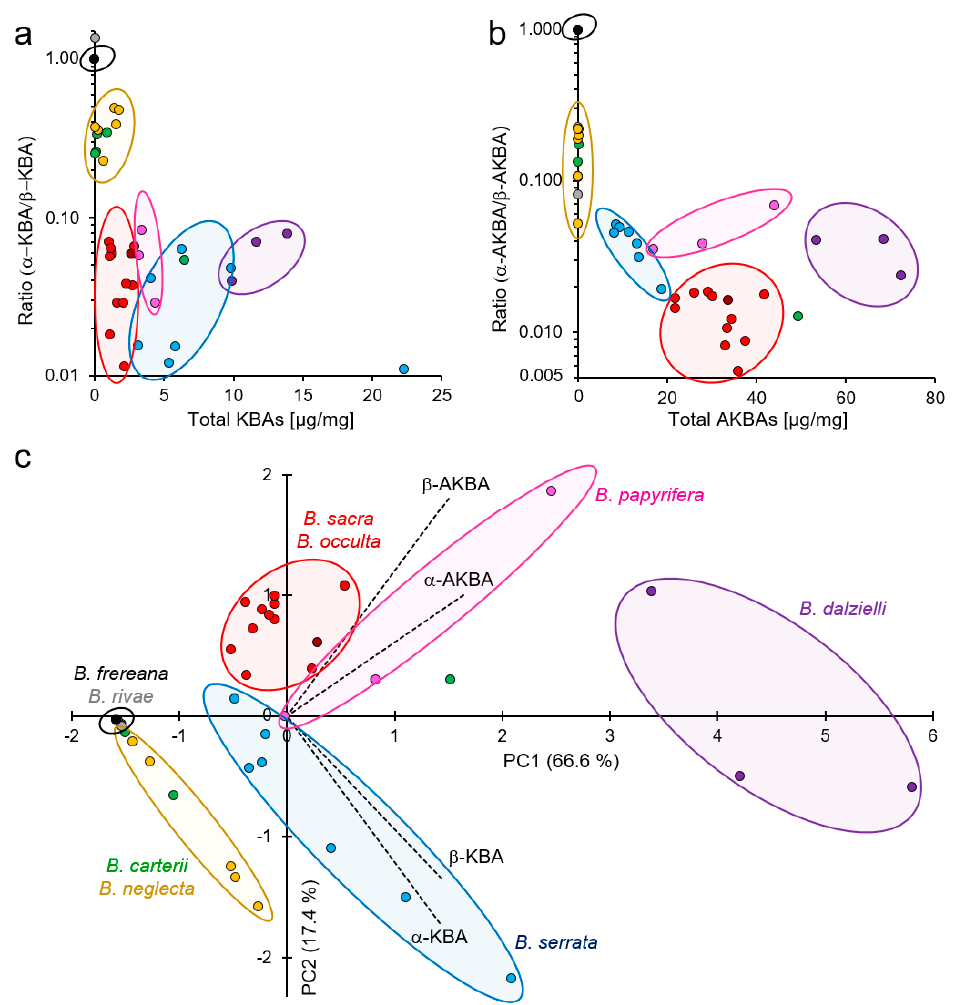
Figure 6. Visualization of variations in composition of 11-keto-boswellic acids (KBAs) and acetyl-11-keto-boswellic acids (AKBAs) in oleogum resins of different Boswellia species. B. sacra (red), B. serrata (blue), B. dalzielli (violet), B. papyrifera (pink), B. carterii (green), B. neglecta (yellow), B. frereana (black), B. rivae (grey), and B. occulta (dark red). ( a ) Semi-logarithmic scatter plot of total KBA contents and ratio between 11-keto- α -boswellic acid ( α -KBA) and 11-keto- β -boswellic acid ( β -KBA). ( b ) Semi-logarithmic scatter plot of total AKBA contents and ratio between acetyl-11-keto- α -boswellic acid ( α -AKBA) and acetyl-11-keto- β -boswellic acid ( β -AKBA). Contents < LOQ were considered as 0.000 µ g/mg and as constitutional isomers ratio of 50/50. ( c ) Biplot of principal component analysis (PCA) with loadings of α -KBA, β -KBA, α -AKBA, and β -AKBA (dashed lines), and individual scores of samples (dots).